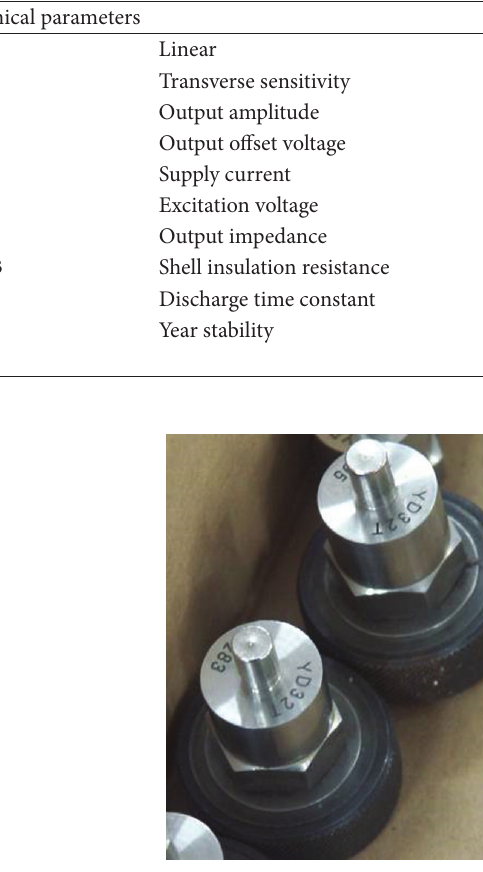
Figure 6: Acceleration transducer.